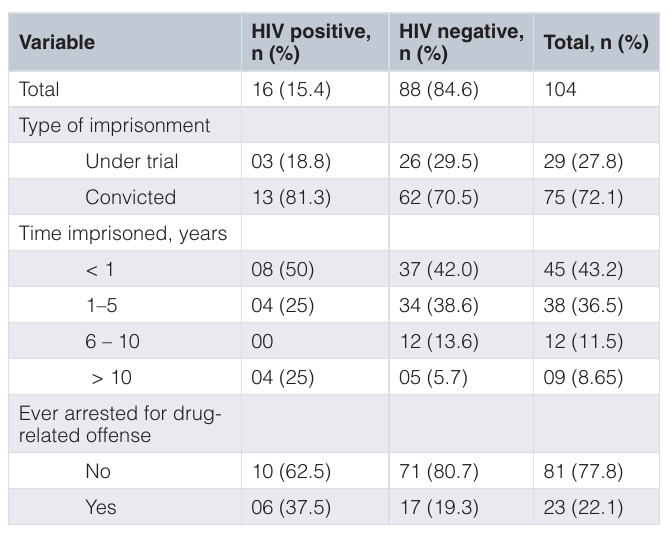
Table 2. Imprisonment status of prisoners in prisons setting of Balochistan evaluated during March-June 2018 (n=104).